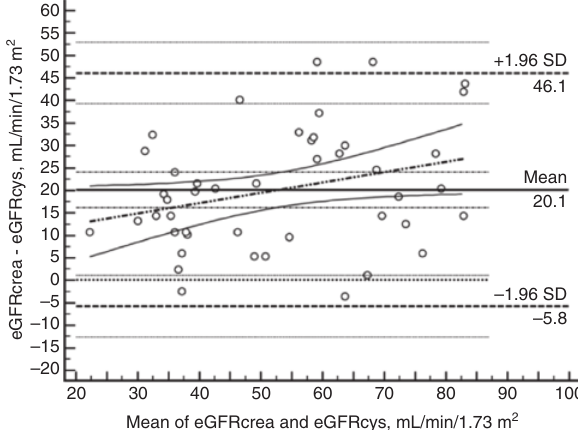
Figure 1: Bland-Altman plot: comparison of the eGFRcrea and eGFRcys in overdosed patients. eGFRcrea, estimated glomerular filtration rate from serum creatinine; eGFRcys, estimated glomerular filtration rate from serum cystatin C; SD, standard